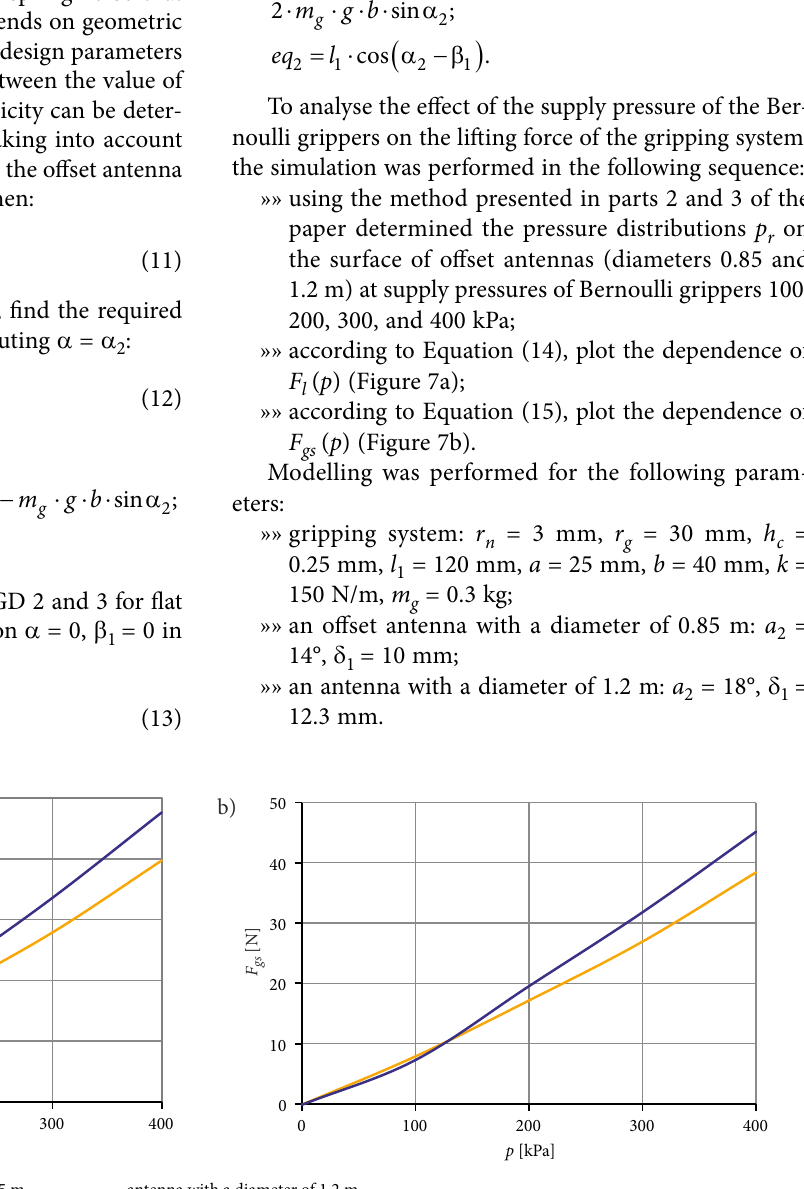
Figure 7. Dependences of the lifting force of offset antennas on the supply pressure: a – one Bernoulli gripper; b – gripping